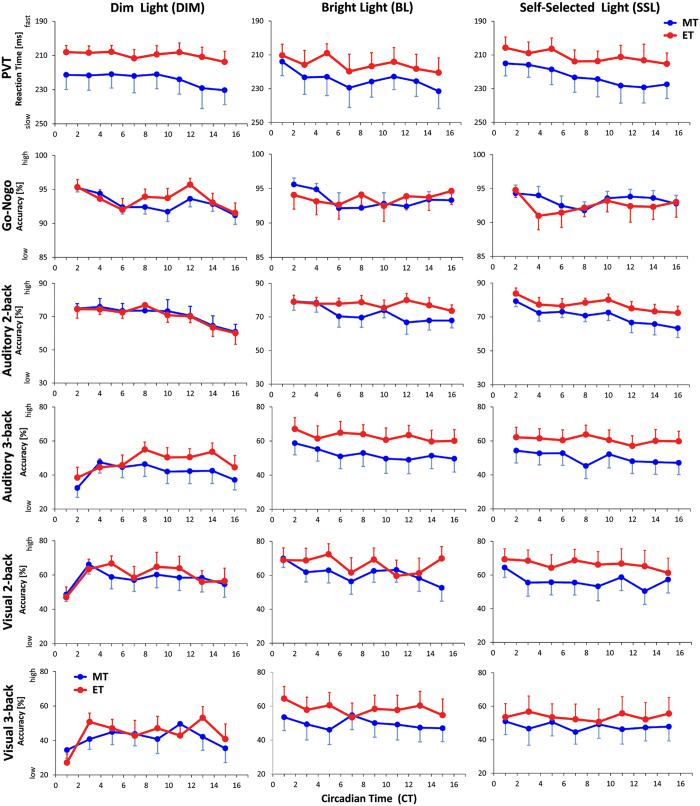
Time course for reaction time in the PVT and accuracy of cognitive performance tests (Go-no-go; auditory 2-, and 3-back; visual 2- and 3-back) for both chronotypes (morning types = blue symbols; evening types = red symbols).DIM = left column; BL = middle column; SSL = right column; N = 32; means; SEM).